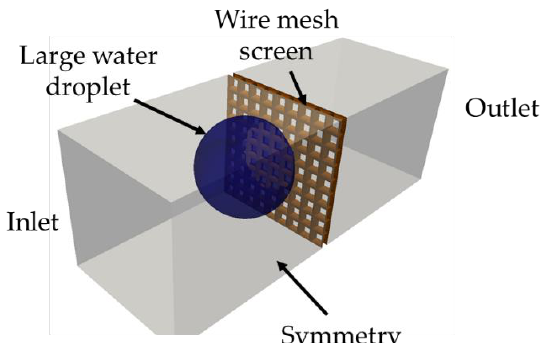
Figure 6. Computational domain for the simulation of the interaction between a large single droplet and wire mesh screen.